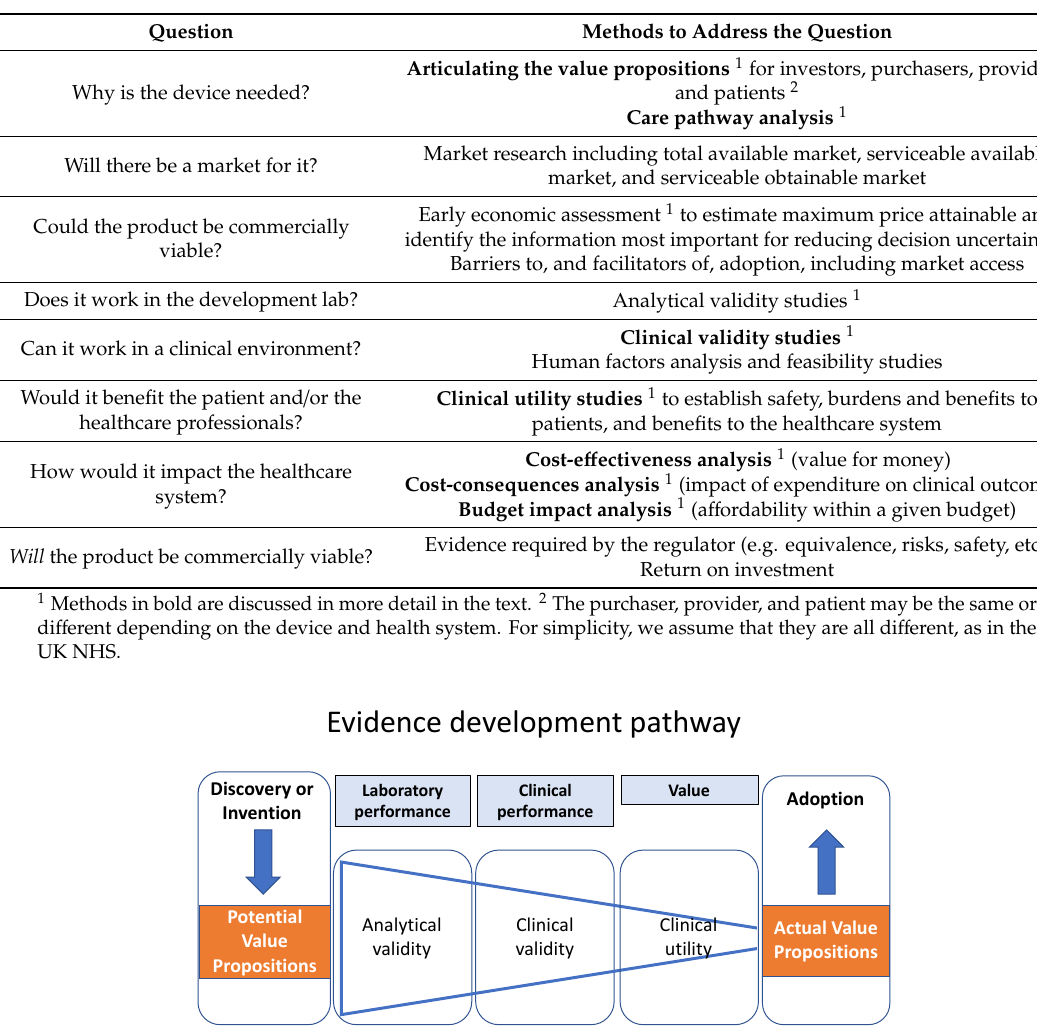
Table 1. Stages of evidence development to bring a medical device / diagnostic to the market.